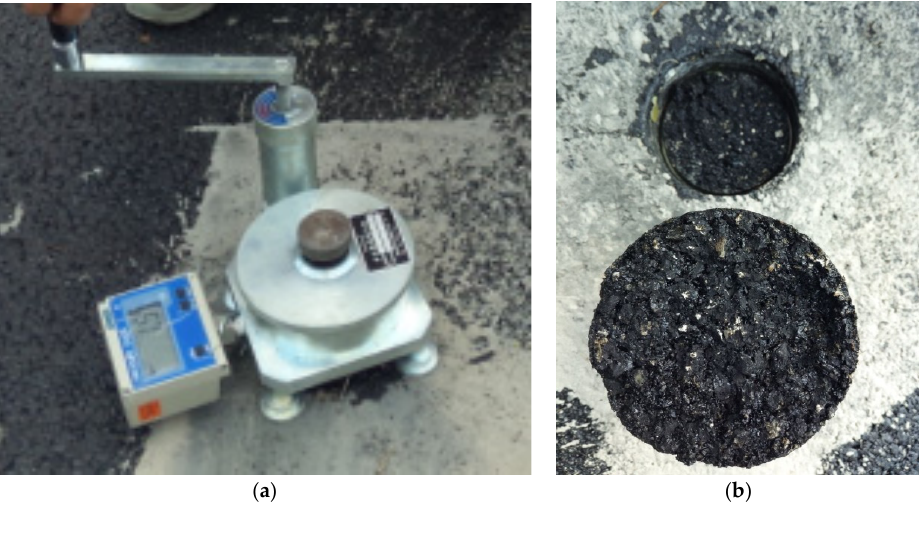
Figure 4. Field pull out test.